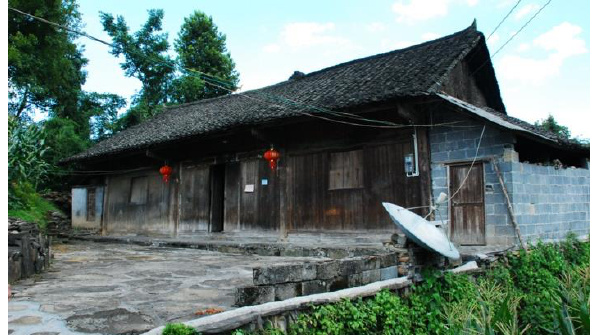
Figure 12. The I-shaped